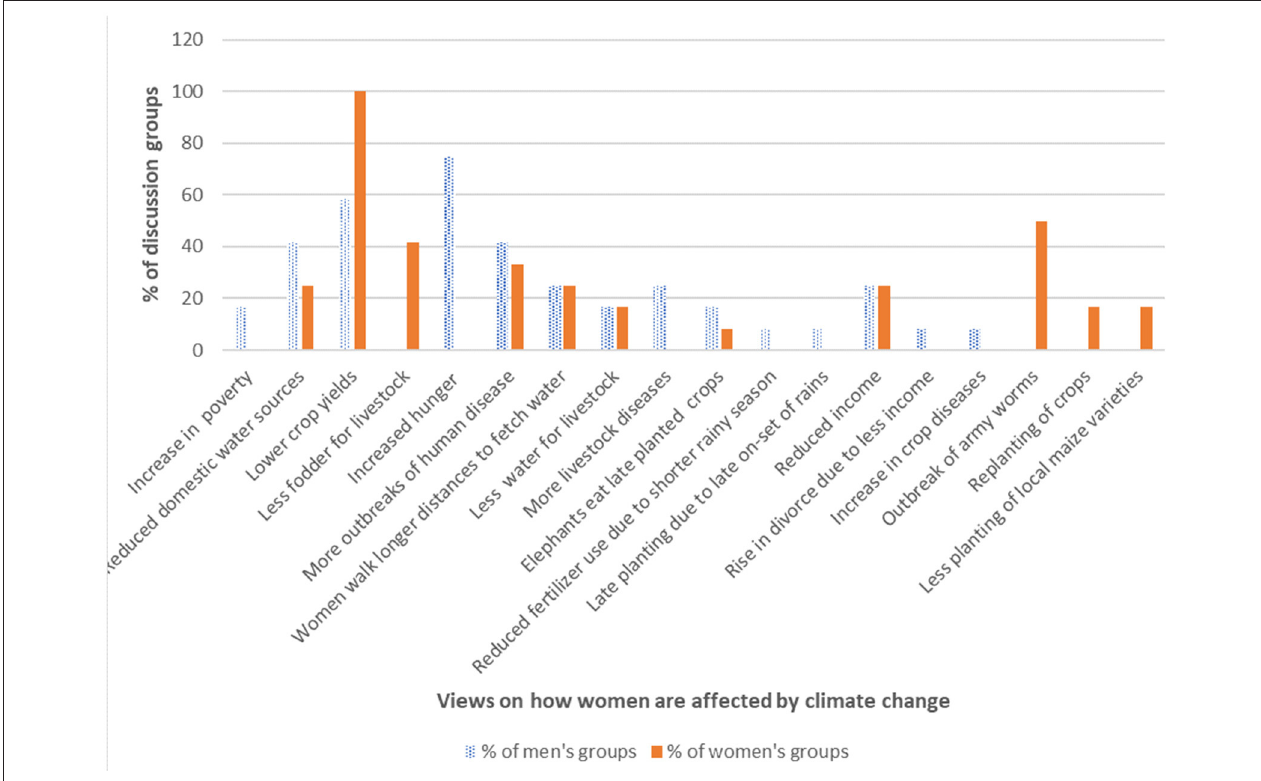
FIGURE 4 | FGDs’ views on how climate change affects